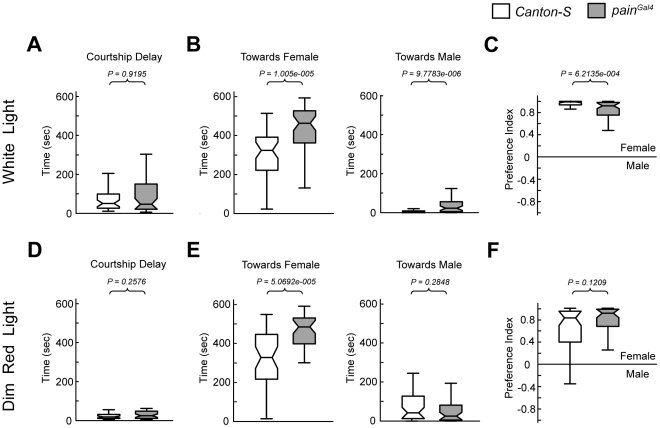

painless mutant males were capable of distinguishing female from male flies.(A) Box plots of courtship delay, which represents the latency before males initiated courtship behavior. (B) Total time spent by each individual male on courting decapitated females (left) and decapitated males (right). (C) Average PI of males of indicated genotypes towards females vs. males. Error bars represent SEM. (D–F) are similar as (A–C) except that these experiments were performed under dim red light instead of under white light as in (A–C). P values were determined by the Kruskal-Wallis test, and 43–48 males were examined in each group.